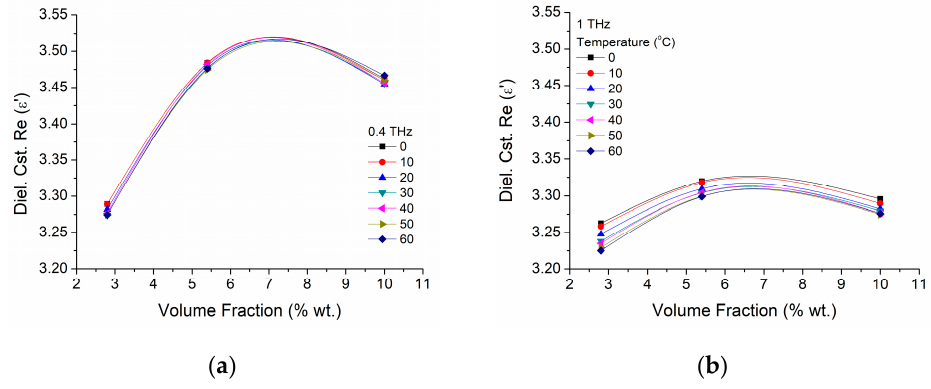
Figure 10. BTO-epoxy dielectric constant real part ( ε′ ) variation on nanoparticle volume fraction variation at different frequencies of ( a ) 400 GHz and ( b ) 1 THz.